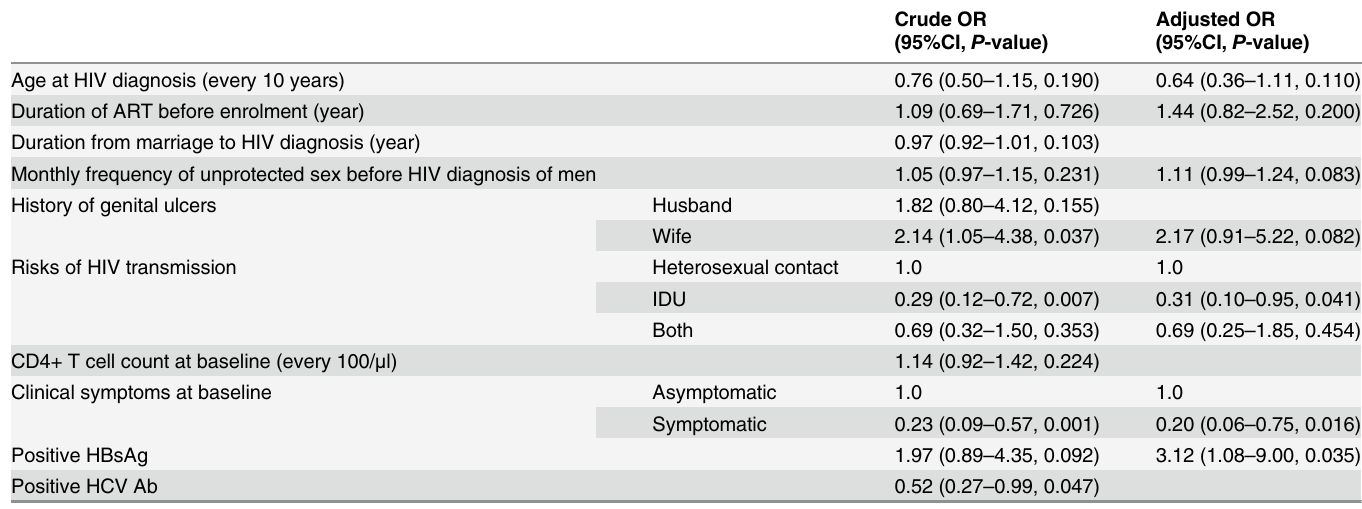
Table 2. Risk factor analysis for men having HIV-positive